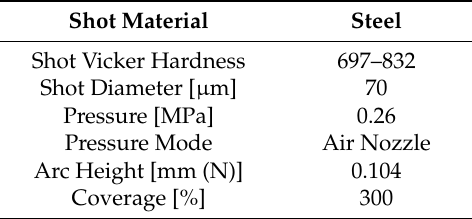
Table 2. Fine particle peening